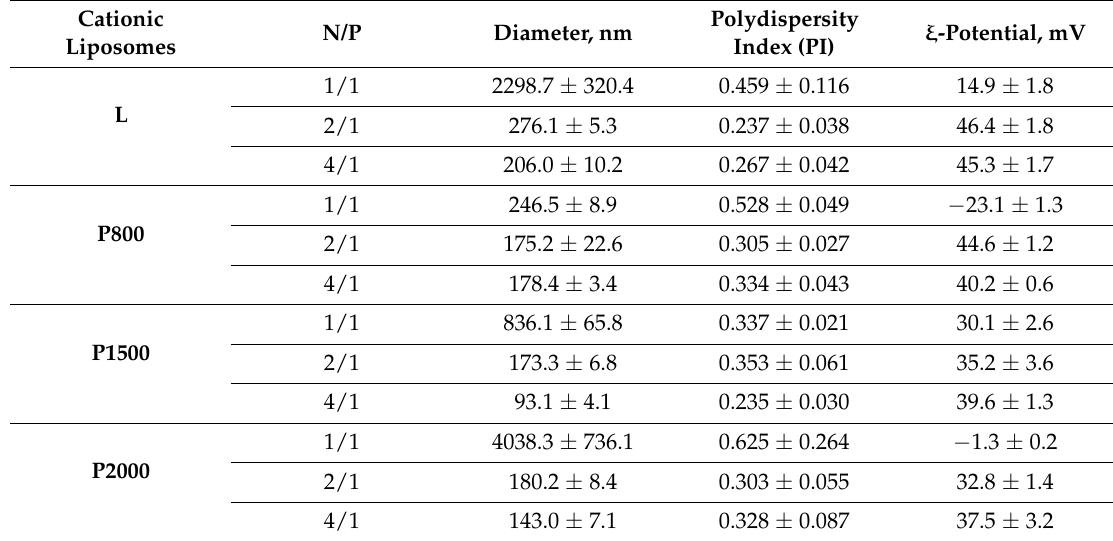
Table 2. Hydrodynamic diameters, polydispersity index and ξ -potentials of lipoplexes formed